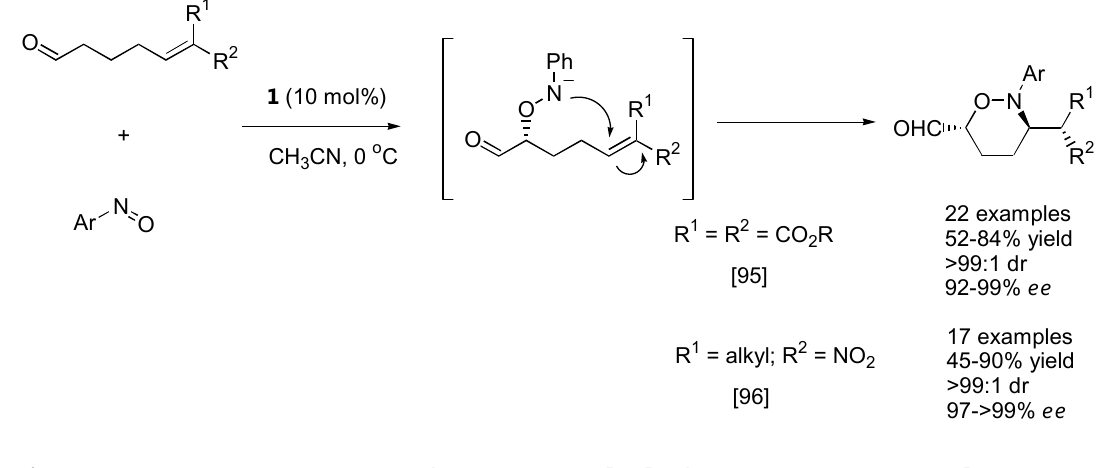
Figure 25. A strategy to synthesize 1,3-polyols by iterative aminoxylation-HWE olefination-reduction sequence